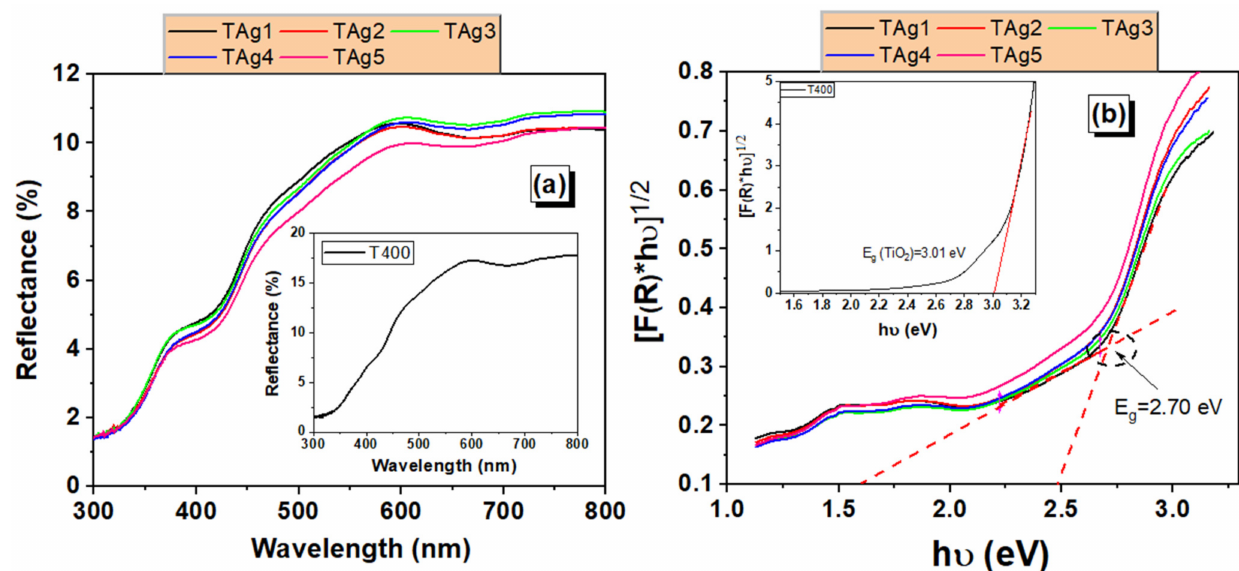
Figure 6. Optical properties: ( a ) reflectance spectra and ( b ) Tauc plots of Ag–TiO 2 nanostructured nanofibers